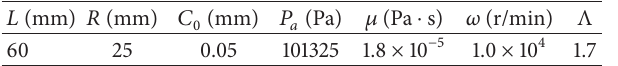
Table 3: Basic parameters of the